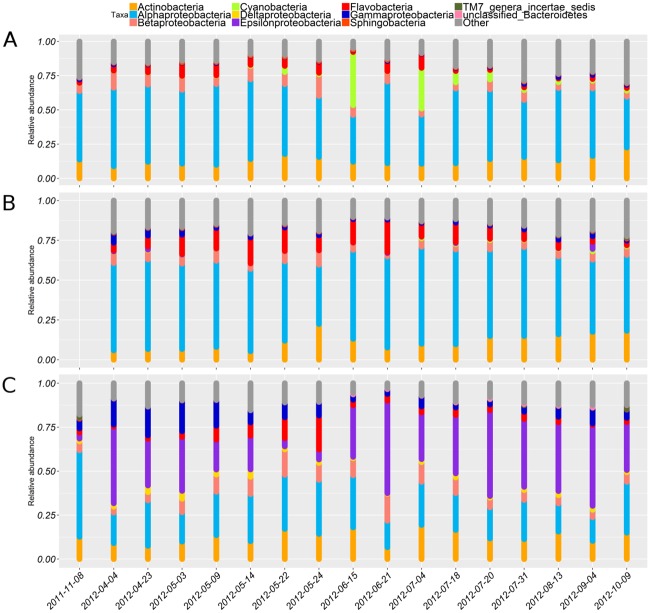
The relative abundance of dominant bacterial classes given in three depth ranges: 5–25 m (A), 25–65 m (B) and >65 m (C).